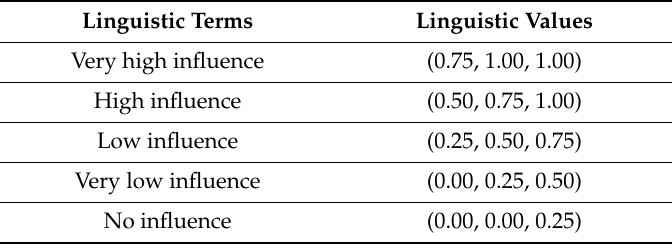
Table 1. The correspondence of linguistic terms and values.